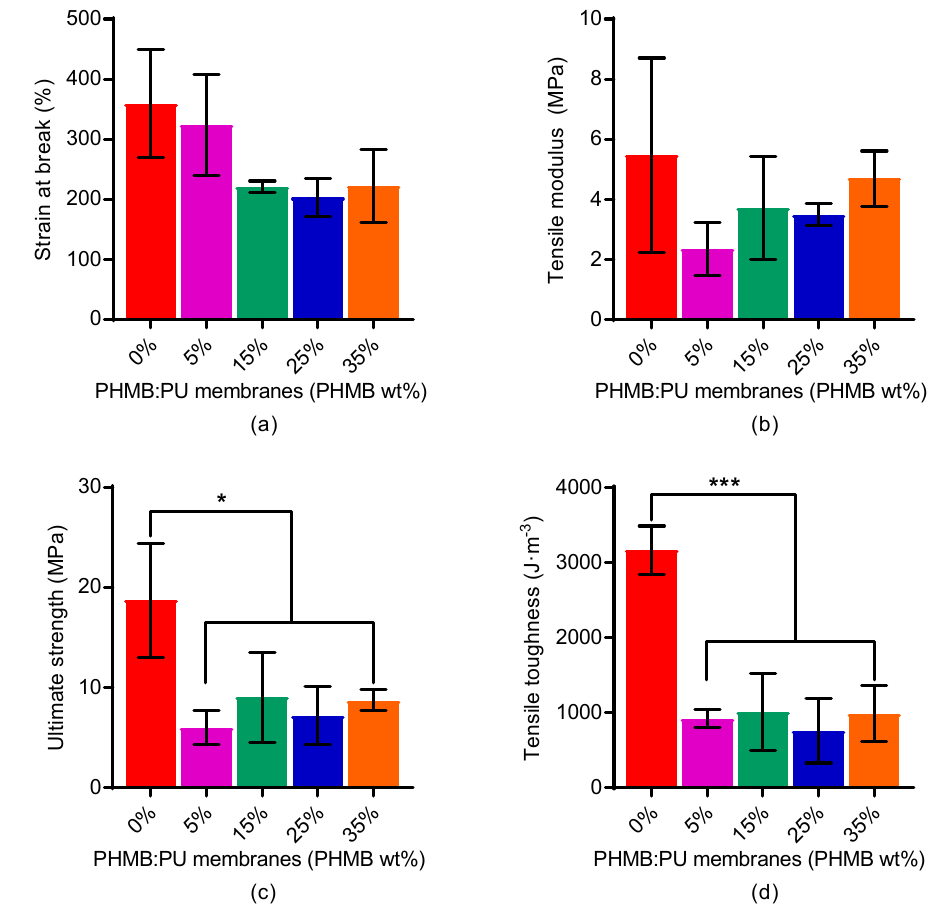
Figure 4. Tensile mechanical properties of electrospun PHMB:PU membranes. ( a ) Strain at break; ( b ) Tensile modulus at 5–10 mm extension; ( c ) Ultimate strength; ( d ) Tensile toughness. Samples tested were the 0-35PHMB:PU electrospun membranes. Error bars describe the standard deviation from the mean, with n = 3. * signifies a significant di ff erence between samples (* for p < 0.05; *** for p <